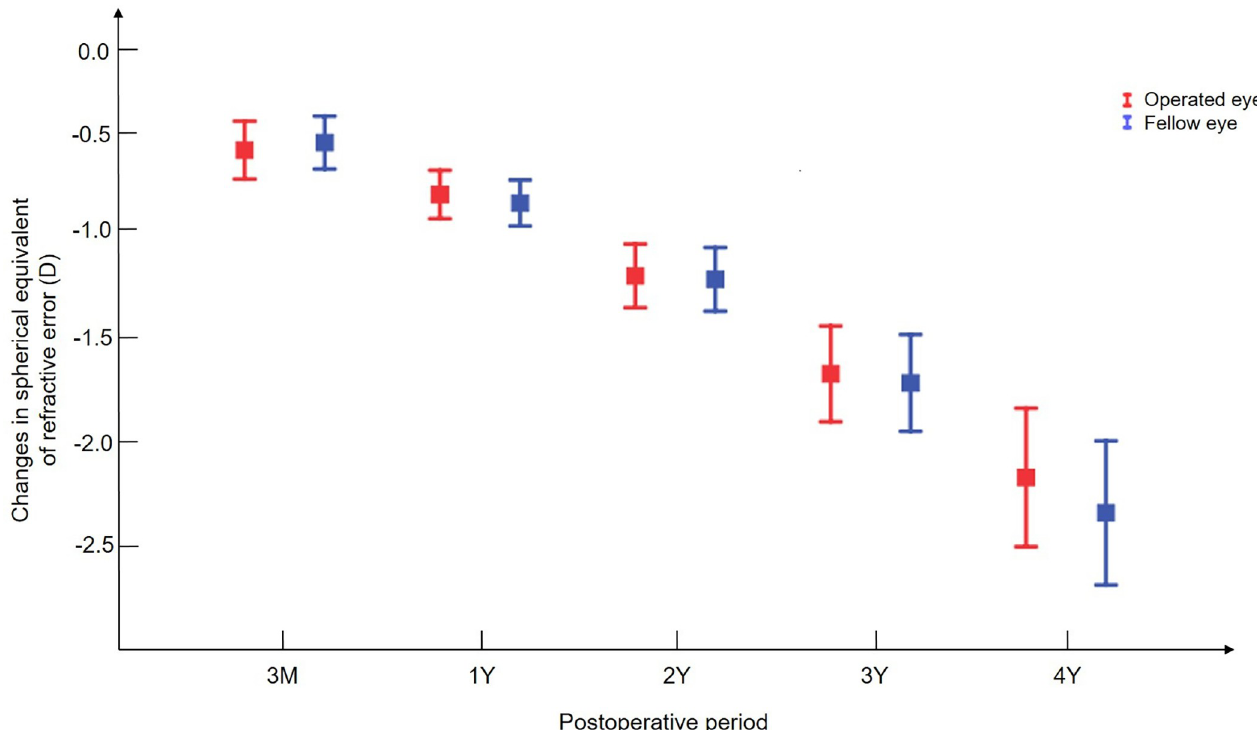
Fig 1. Changes in the spherical equivalent of the refractive error of both eyes over time. The course of the operated eyes is presented as blue lines and that of the fellow eyes as red lines. The error bar indicates the standard error of the mean.